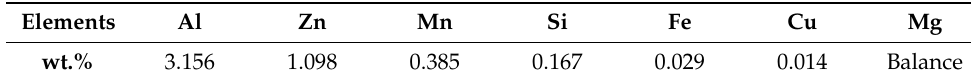
Table 1. Composition of the matrix magnesium alloy (wt.%). Elements Al Zn Mn Si Fe Cu Mg wt.%